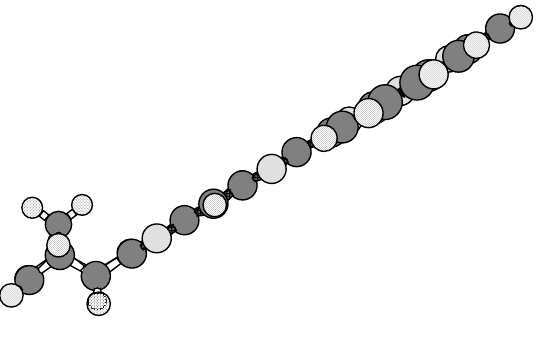
Figure 2: Molecular modeling (AM1) of the porphyrin block 8